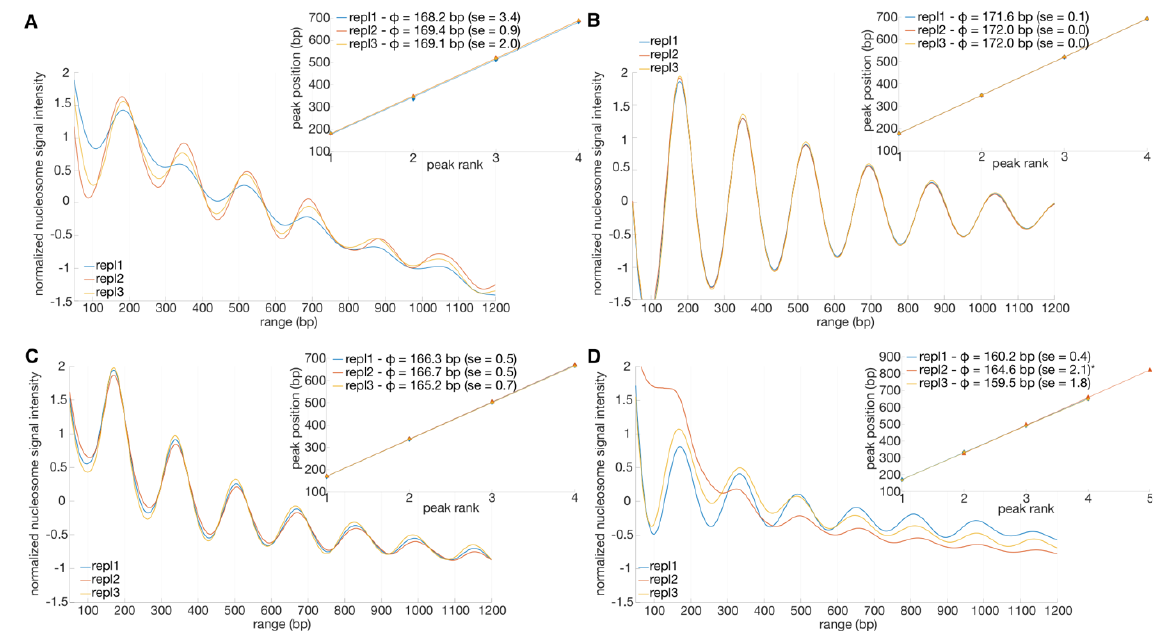
Figure 1: Nucleosome phasing in the four fungi studied. Main graphs display scaled (z-score) phase frequencies (y-axis) as a function of position (in base pair; x-axis). Graphs in inserts show peak positions (in base pairs; y-axis) as a function of peak order (x-axis). For each replicate, phases, standard errors (se), R 2 (coefficient of determination), and p -values ( F -test) are determined after linear regression fitting to the first four successive peak positions (see Supplementary Table 2). Repl = replicate. A. Botrytis cinerea ; B. Fusarium graminearum ; here, phase value in replicate #2 was measured for four successive peaks excluding peak #1 for which an apex was not clearly visible at the beginning of the profile; C. Leptosphaeria maculans ‘brassicae’; D. Leptosphaeria maculans